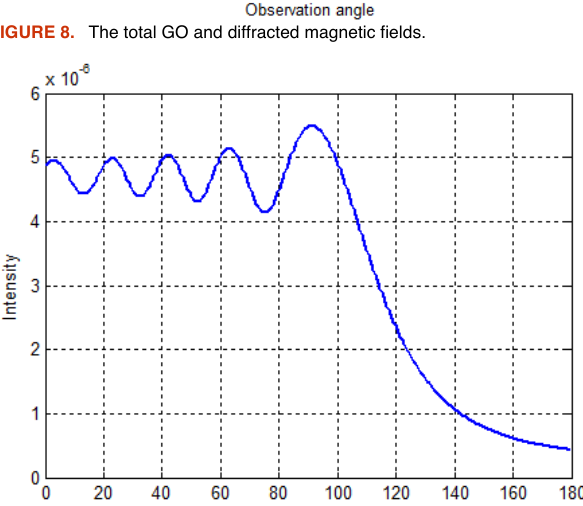
FIGURE 9. The total magnetic